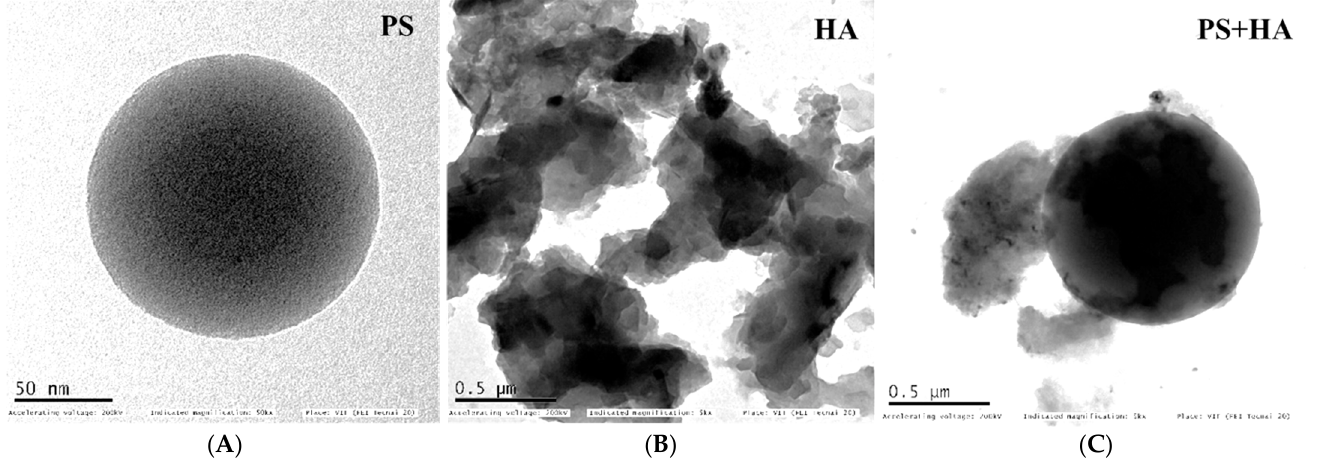
Figure 1. Transmission electron microscopy (TEM) image of PS, HA & PS + HA dispersed in Milli- Q water.